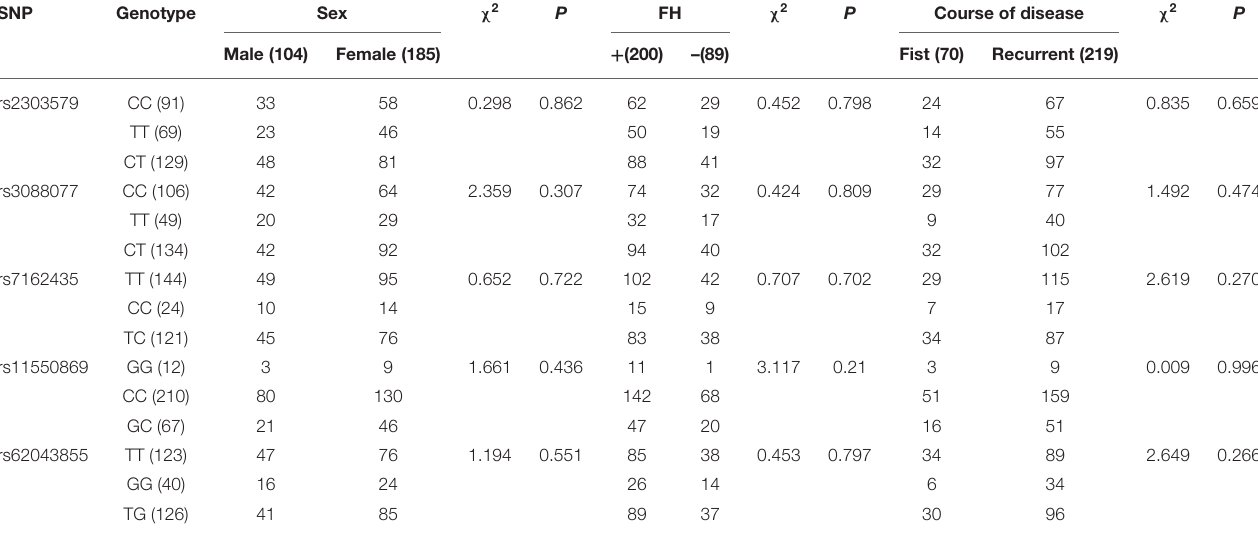
TABLE 1 | One-way analysis of among genotype distributions and gender, FH, course of disease.